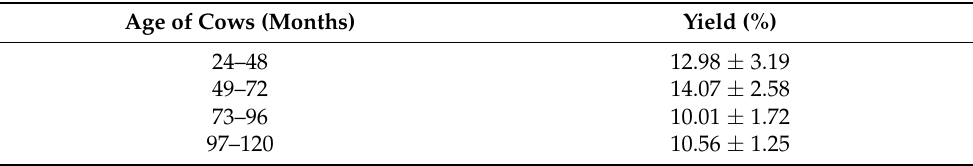
Table 2. Yield of PRP in different ages of cows.